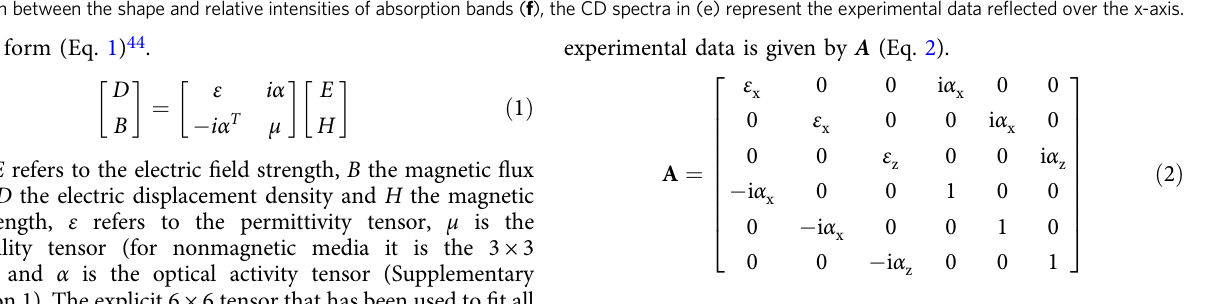
Fig. 2 Absorbance and circular dichroism (CD) of 130 nm ACPCA and CSCP thin fi lms. CD of ACPCA ( P - aza[6]H) (PFO: black, F8BT: red and F8T2: blue lines) and CSCP (cPFO: turquoise, cPFBT: purple lines) thin fi lms measured ( a , d ) before and ( b , e *) after annealing for 10min at 140°C and being removed from the heat source. The absorption spectra, recorded after annealing, normalised to the lowest energy transition, are also provided ( c , f ). The inset of ( a ) shows a 500-fold zoom of the CD spectrum, revealing the CD signature of the trace additive aza[6]H in the c. 200 – 400nm region. *To allow for direct comparison between the shape and relative intensities of absorption bands ( f ), the CD spectra in (e) represent the experimental data re fl ected over the